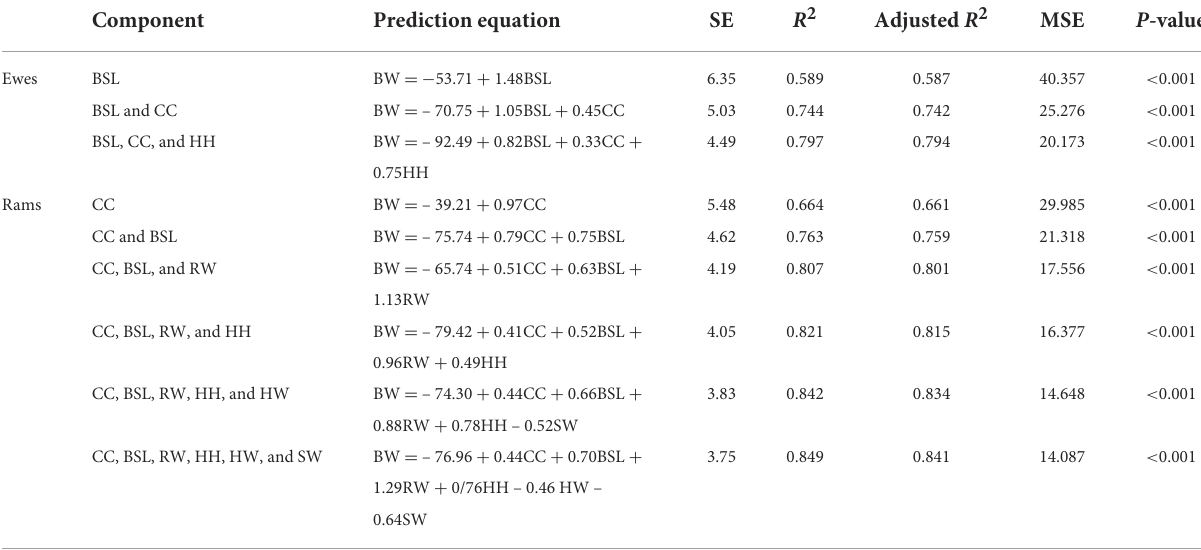
TABLE 3 Regression equations for different